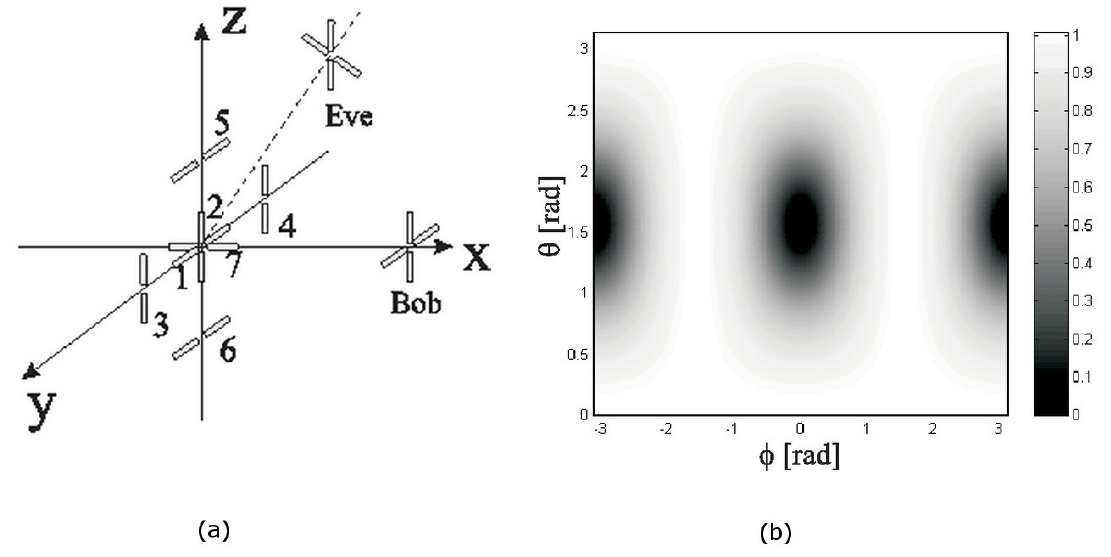
Figure 5. Geometry of the problem; Alice’s antenna consists of 7 short dipoles; ( a ) geometry of the problem; ( b ) ∆ I [bits/s/Hz], 7 TX dipoles, P s = 15 W, P i = 15